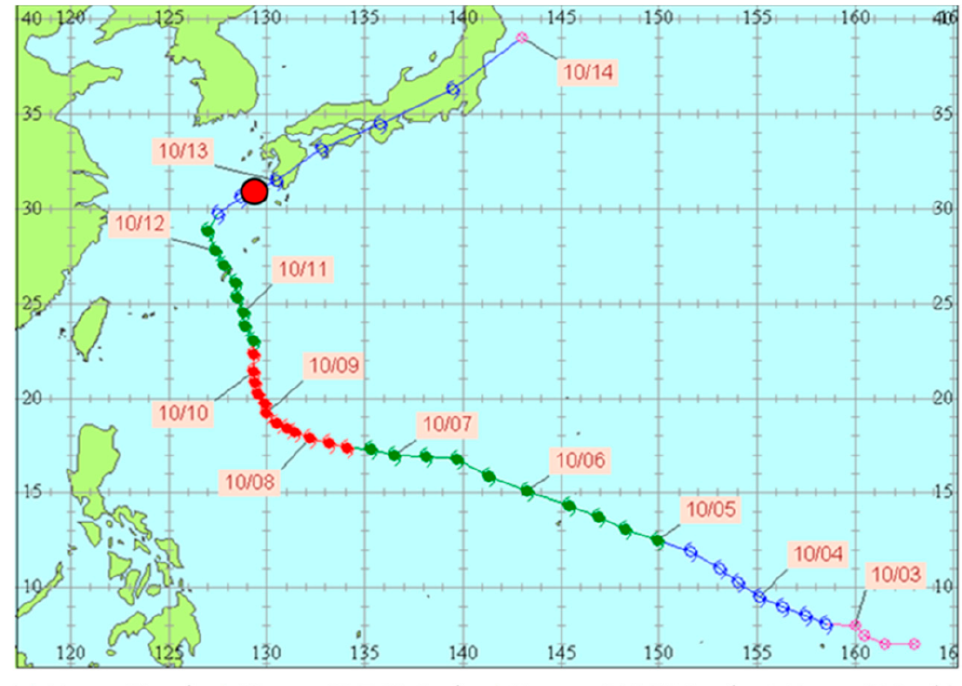
Figure 2. Track of Typhoon Vongfong. The red point is the position of the typhoon when the CFW occurred. Vmax is the maximum wind speed near typhoon